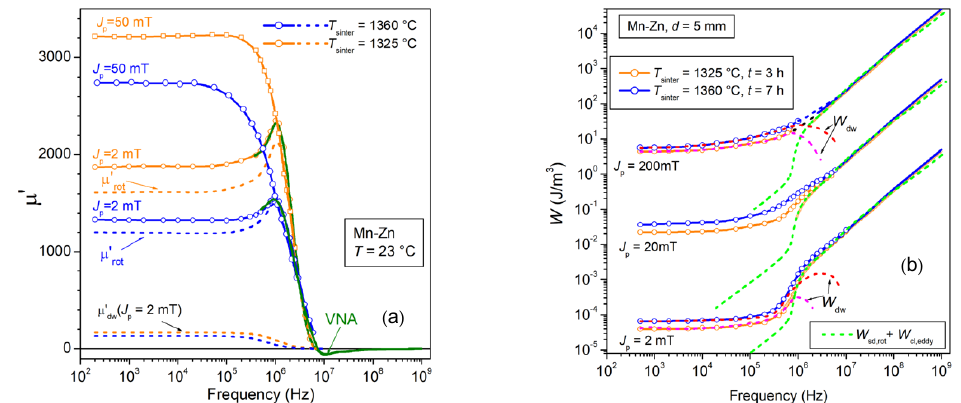
Figure 9. ( a ) The decrease in the permeability of the Mn-Zn ring samples occurring upon the increase in the sintering temperature T sinter from 1325 °C to 1360 °C is shared by the rotational μ′ rot and dw μ′ dw components. By interpreting Equation (15) in terms of effective magnetic anisotropy, the de- crease in μ′ rot,DC descends from a variation of < K eff > from 50 J/m 3 to 67 J/m 3 following the increase of T sinter to 1360 °C. ( b )The additional structural inhomogeneities brought about by higher T sinter lead to higher dw energy and stronger pinning centers. The dw contribution W dw ( f ) = W h + W exc,sd ( f ) to the measured loss W ( f ) is correspondingly enhanced and survives up to higher frequencies, as concluded after subtracting the predicted high-frequency component W rot,sd ( f ) + W cl,eddy ( f ) from W ( f